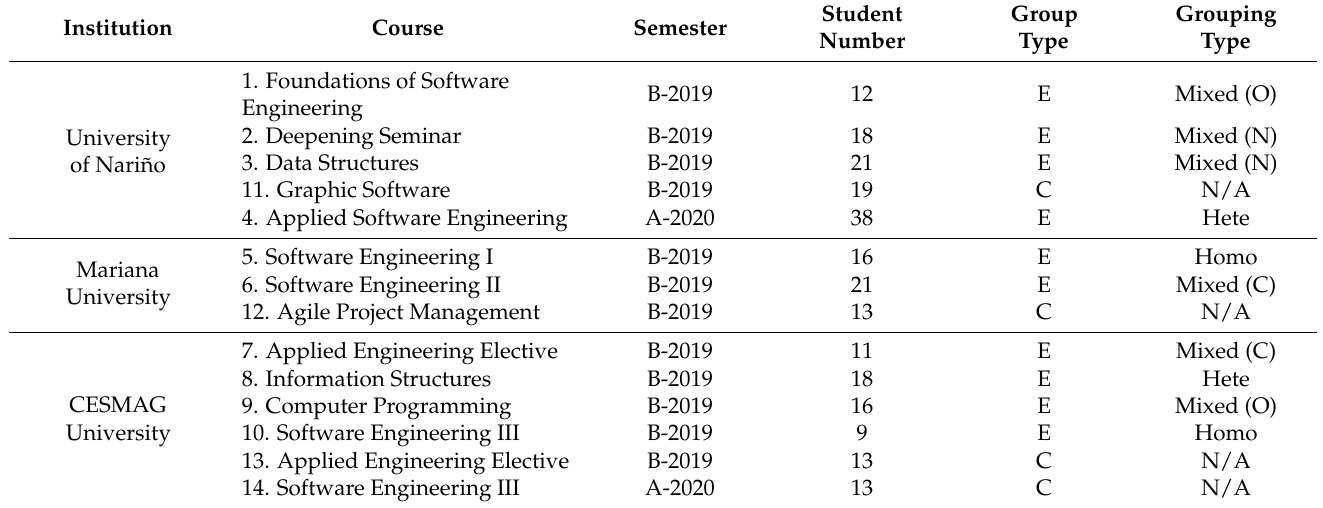
Table 7. Characterization of the working